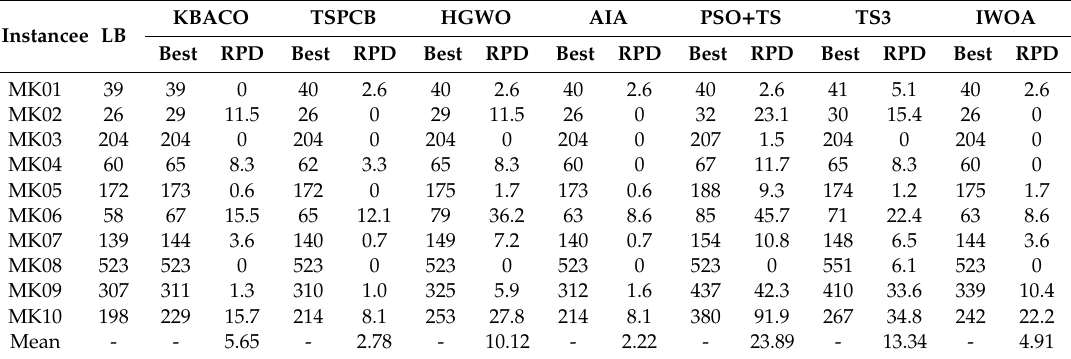
Table 3. Comparison between di ff erent algorithms on the